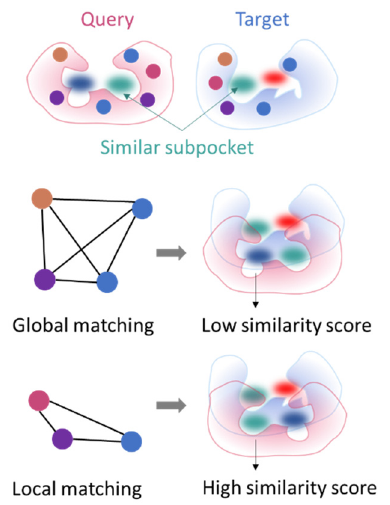
Figure 5. Global versus local pattern comparison.